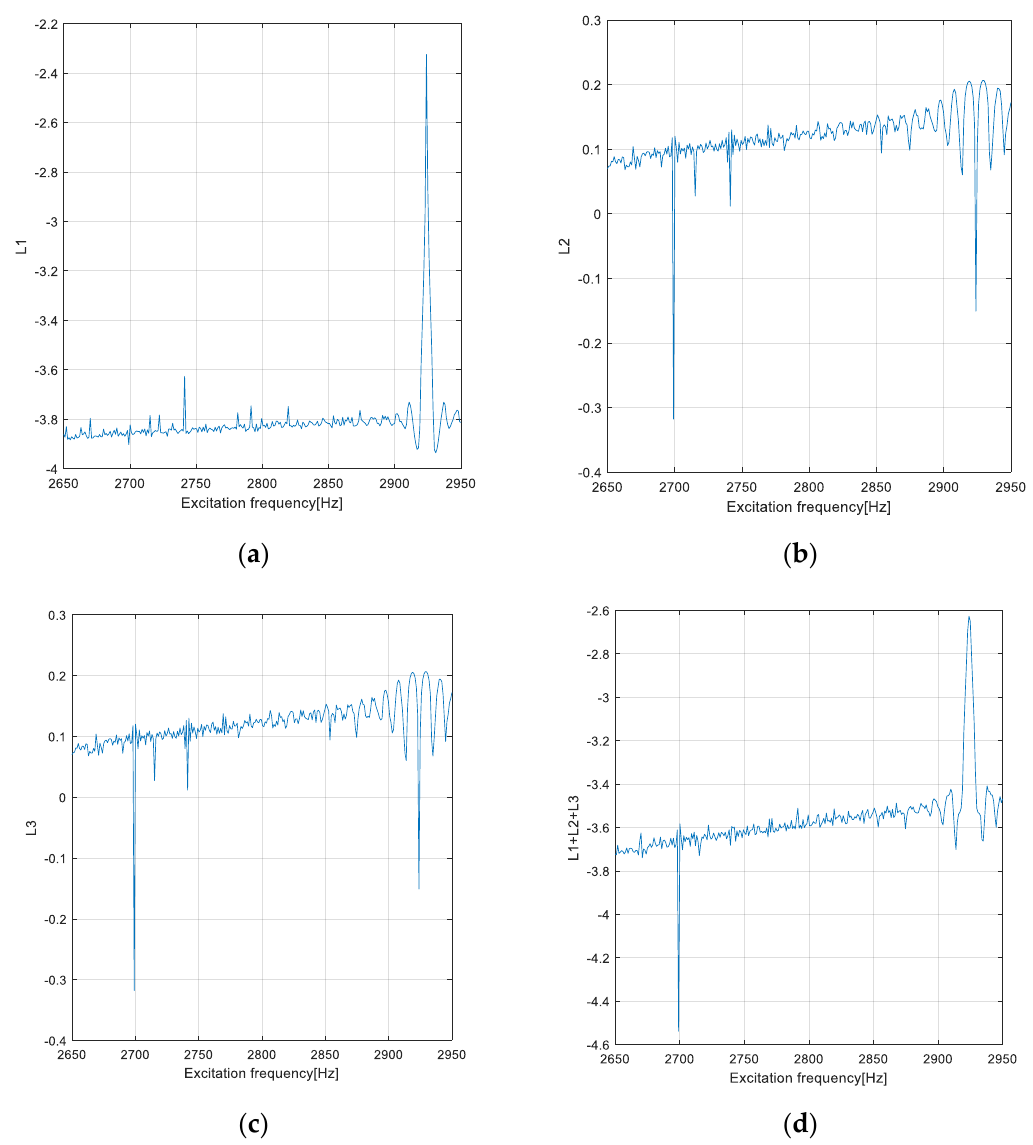
Figure 23. Lyapunov exponents of NFTV for DOE3, β